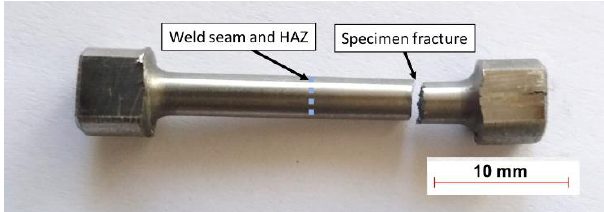
Figure 8. General view of fractured Ti-TiB welded specimen.